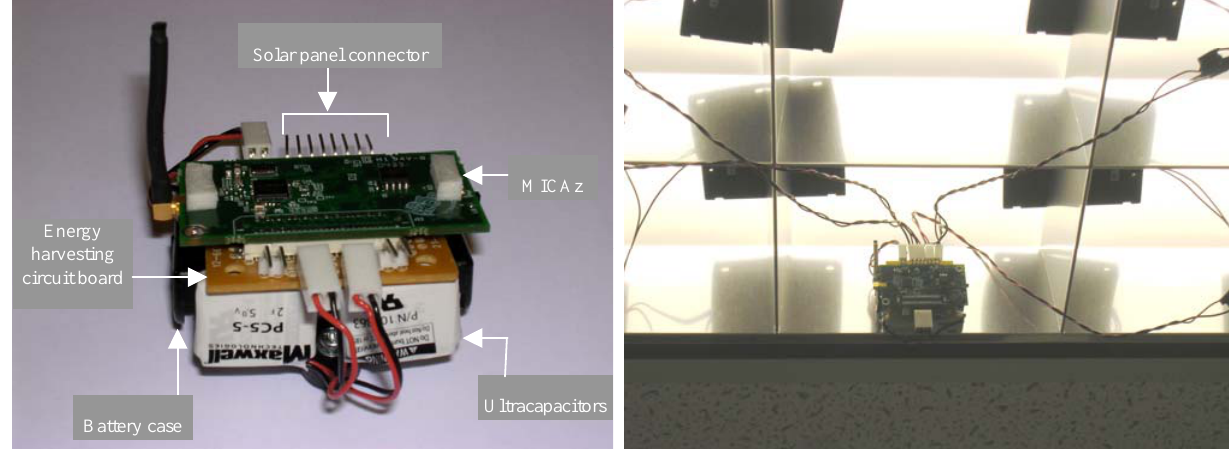
Figure 6a. Router node prototype. Figure 6b. Typical router node